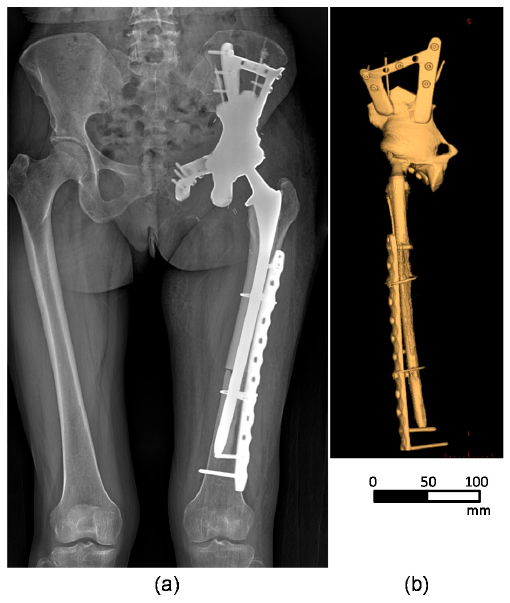
Figure 6. Post-operative medical images of the pelvis area obtained from a patient: ( a ) plain radiograph and ( b ) 3D CT images.